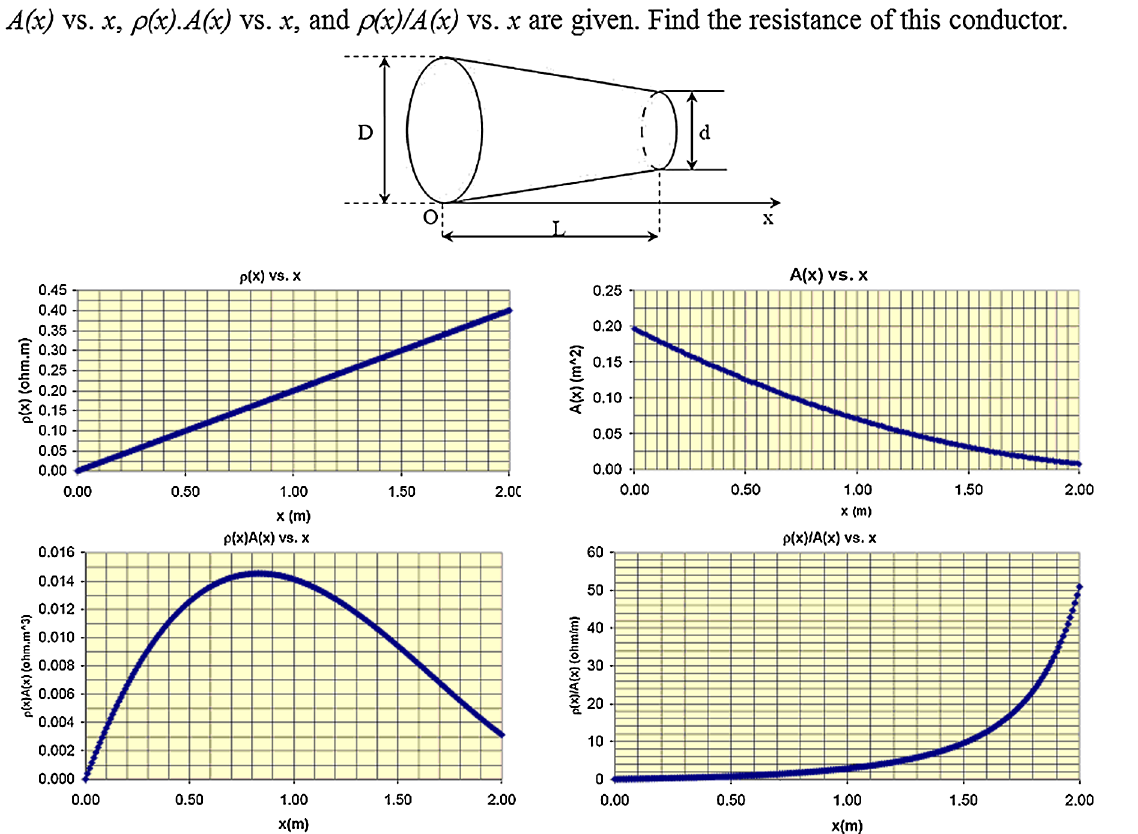
FIG. 5 (color online). The conductor problem (interview